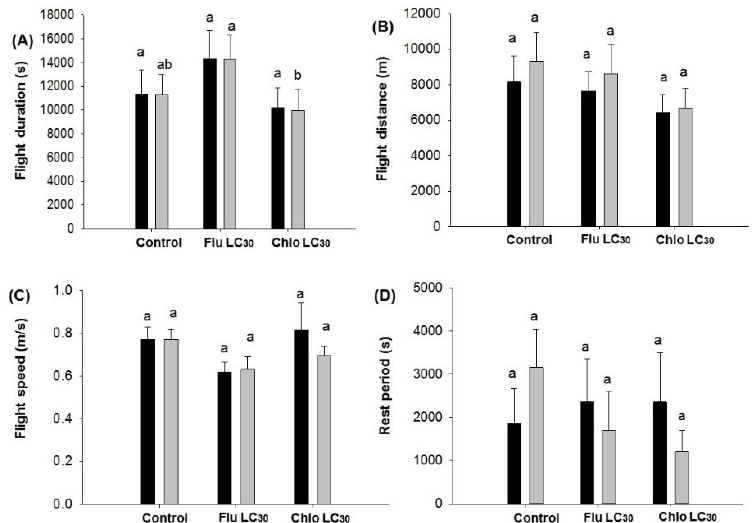
Figure 2. Chloridea virescens sustained flights greater than 30 min: ( A ) Mean flight duration, ( B ) mean flight distance, ( C ) mean flight speed, ( D ) mean rest period. The black bars represent female and grey bars represent male moths. Di ff erent letters above the standard error bars indicate significant di ff erences based on Tukey–Kramer test ( p < 0.05).